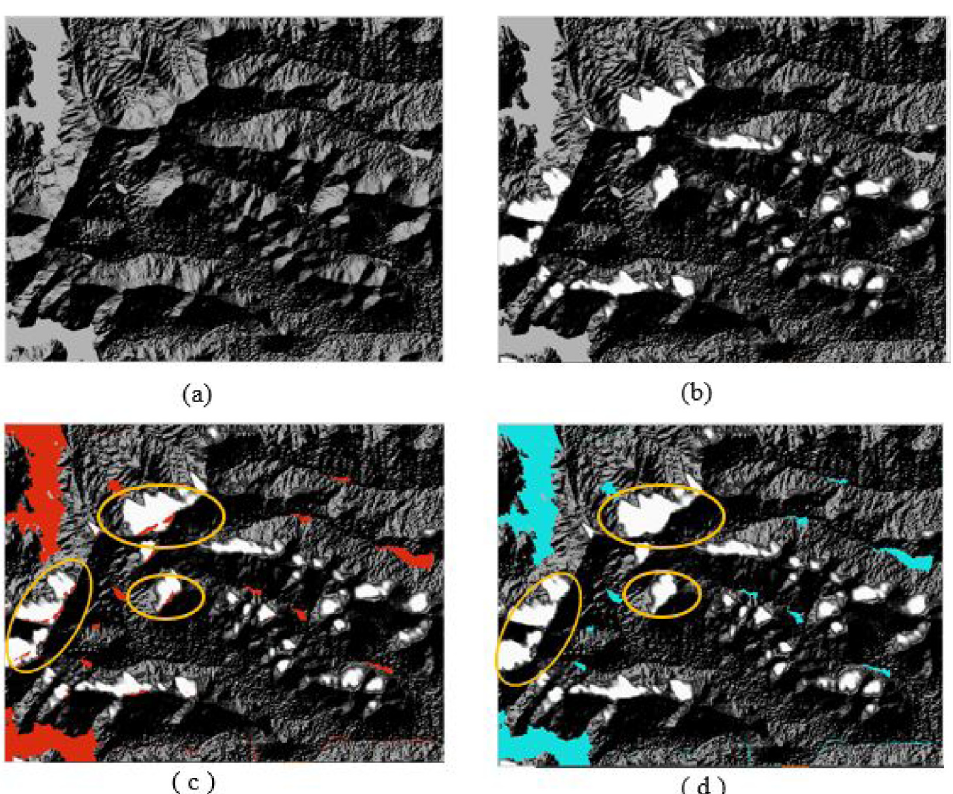
Figure 6. ( a ) Digital Elevation Model (DEM) of Pune. ( b ) Mountain shadow depth derived from DEM. ( c ) Misclassified mountain shadows as water (red area is water and white area is mountain shadow). ( d ) Integrating shadow depth with binary Modified Normalized Difference Water Index (MNDWI) image to remove misclassified water. Landsat 8 image courtesy of the U.S. Geological